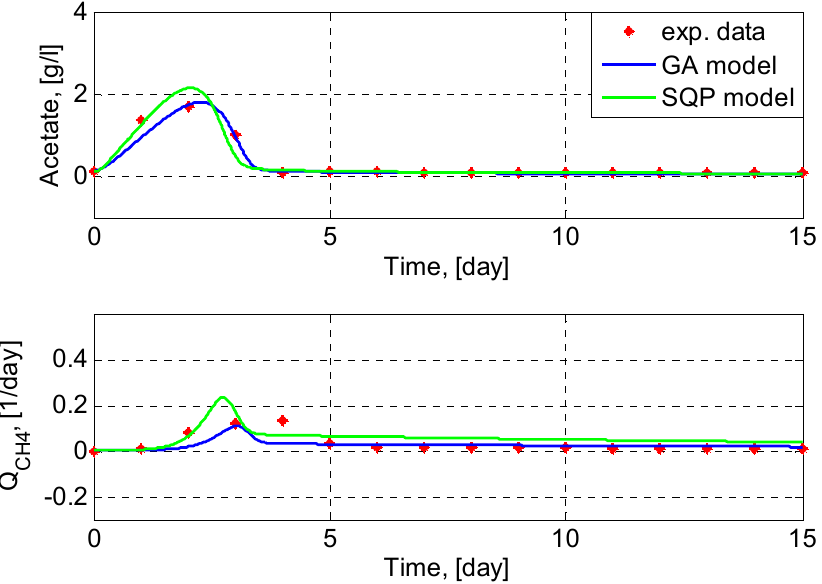
Figure 2. Comparison of the experimental data and model predictions for acetate and methane obtained by GA and SQP models—identification results.